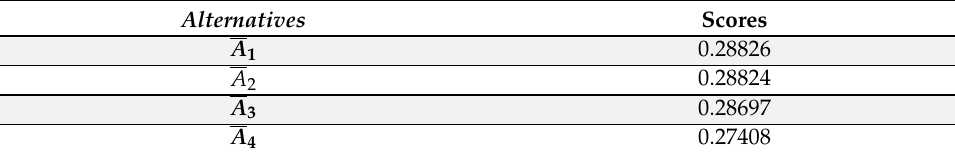
Table 19. Score Values of the aggregated values in Table 17.